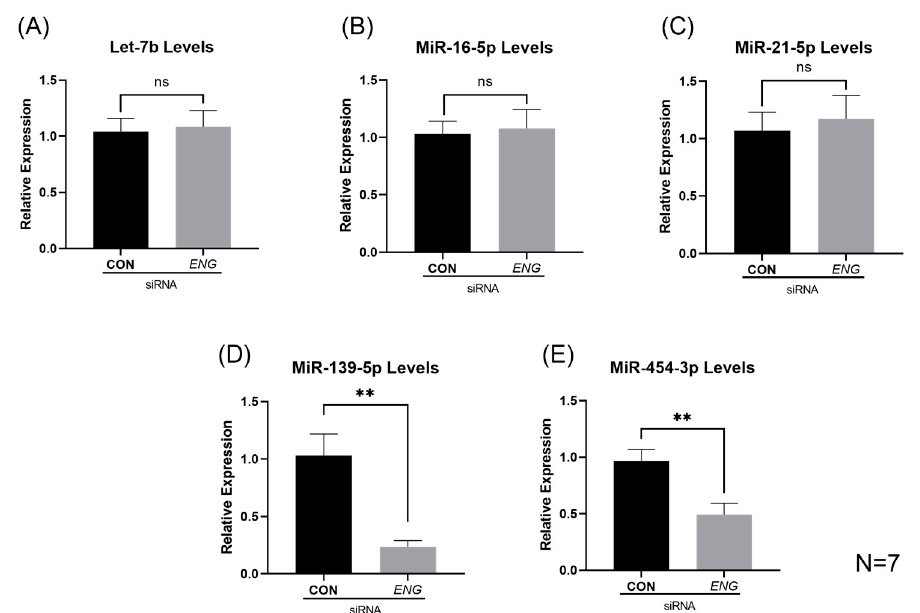
Figure 3. RT-qPCR validation of miRs-let-7b, -16-5p, -21-5p, -139-5p and -454-3p. ( A – C ) MiRs-let-7b, -16-5p and -21-5p were not found to be significantly decreased in ENG -knockdown HUVECs. ( D , E ) MiRs-139-5p and -454-3p were found to be significantly decreased in ENG -knockdown HUVECs compared with those in negative control siRNA HUVECs. ns: not significant, ** p < 0.01.